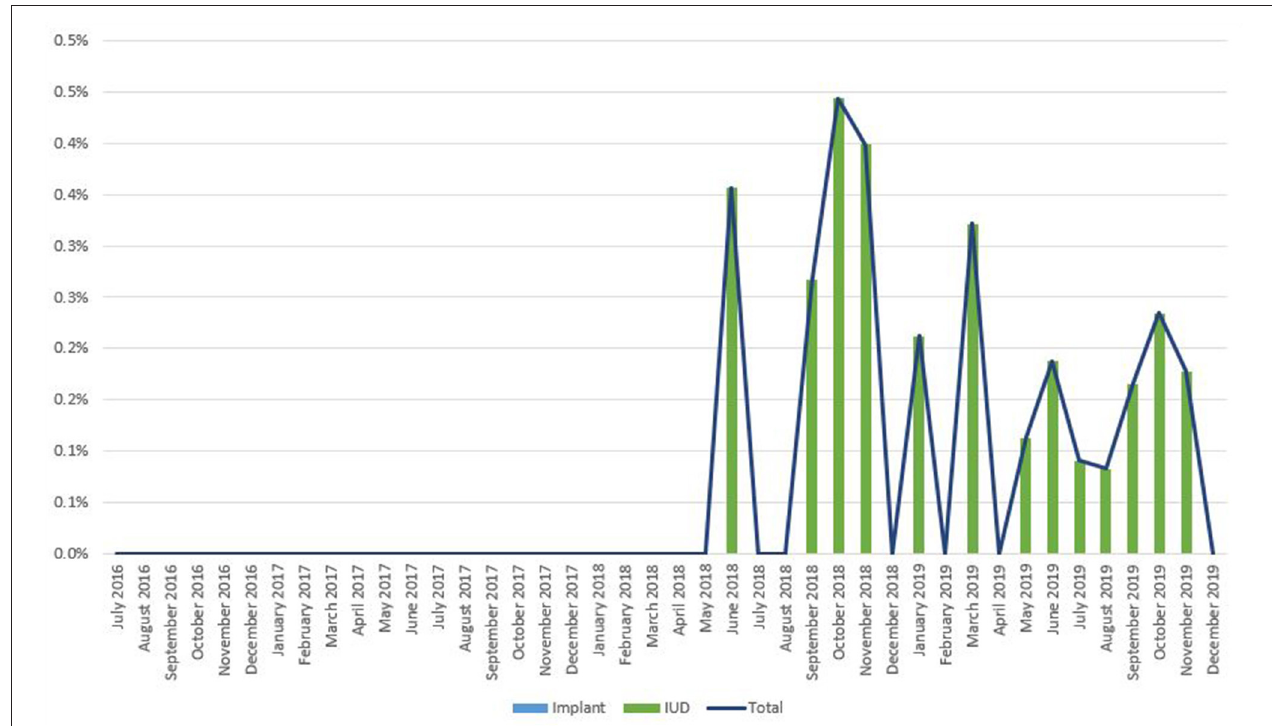
FIGURE 8 | Immediate postpartum IUD and implant uptake among all facility-based deliveries, July 2016-December 2019,